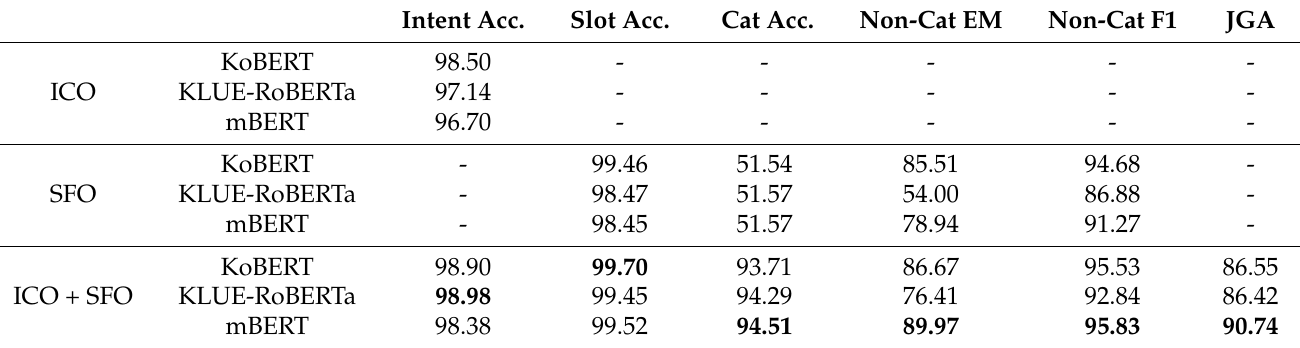
Table 4. Main Experimental Results. ICO denotes the model that trains with intent classification only, and SFO indicates the model that is learned with slot-filling only. Acc. is the abbreviation of accuracy. Intent